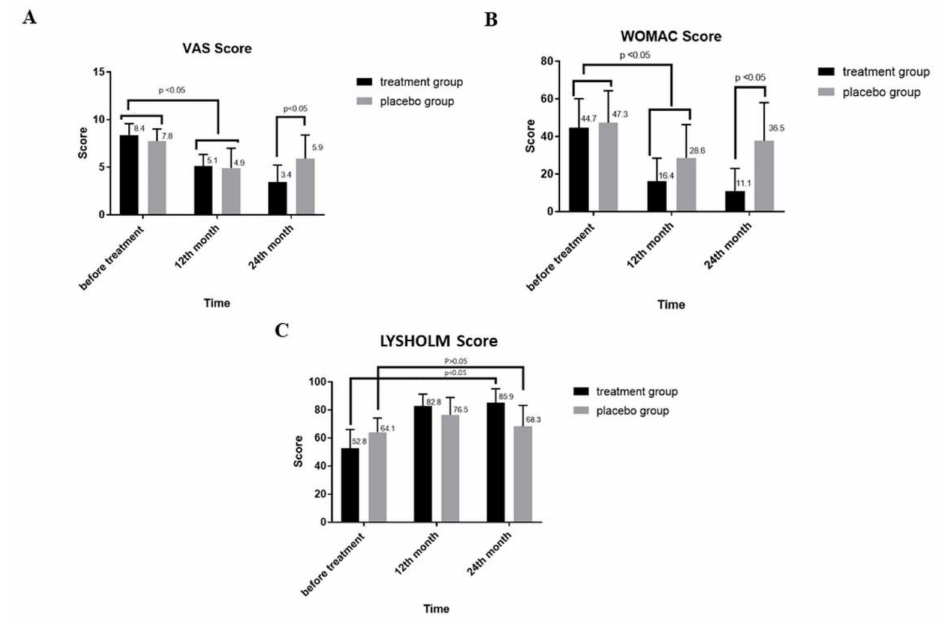
Figure 2. Assessment of clinical outcomes of OA patients treated with SVF at 12 and 24 months. ( A ) Visual analogue scale (VAS) score ( B ) Western Ontario and McMaster Universities Arthritis Index (WOMAC) index, and ( C ) Lysholm score of the SVF-treated group compared to the placebo